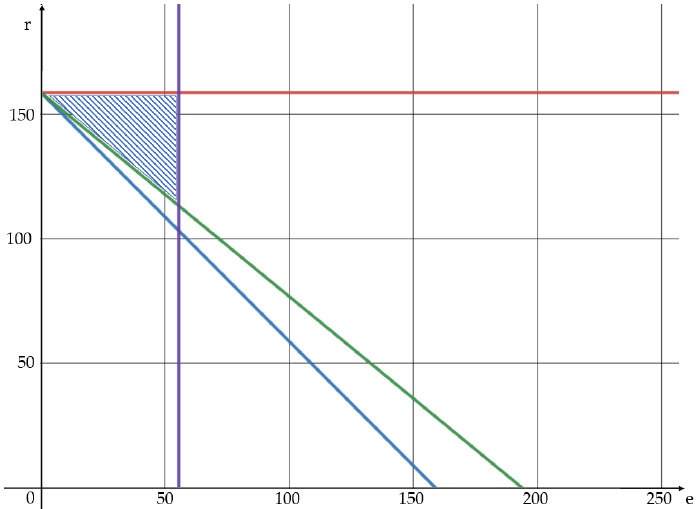
Figure 5. Graph showing the optimization area of eccentricity(e) and radius(r). The optimized values are in the shaded area in Figure 5. The number of teeth of the gear must be an integer, and therefore it is set to 54, which is the closest multiple of 3 to 55.52 mm. At this time, the radius of the pulley must be 113.5 mm or more, and the